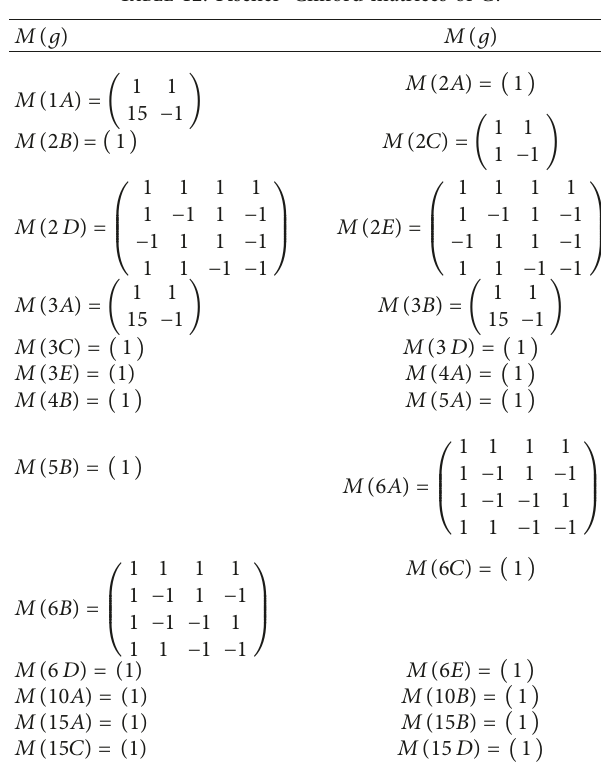
Table 13: Classes of G . Table 12: Fischer–Clifford matrices of G